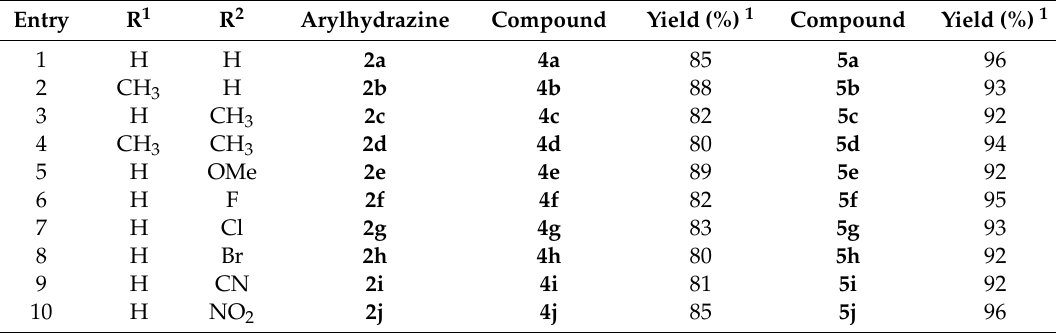
Table 1. Yields of ring A-fused arylpyrazole derivatives of DHT obtained by Method C ( 4a–j ) and subsequent oxidation ( 5a–j ).